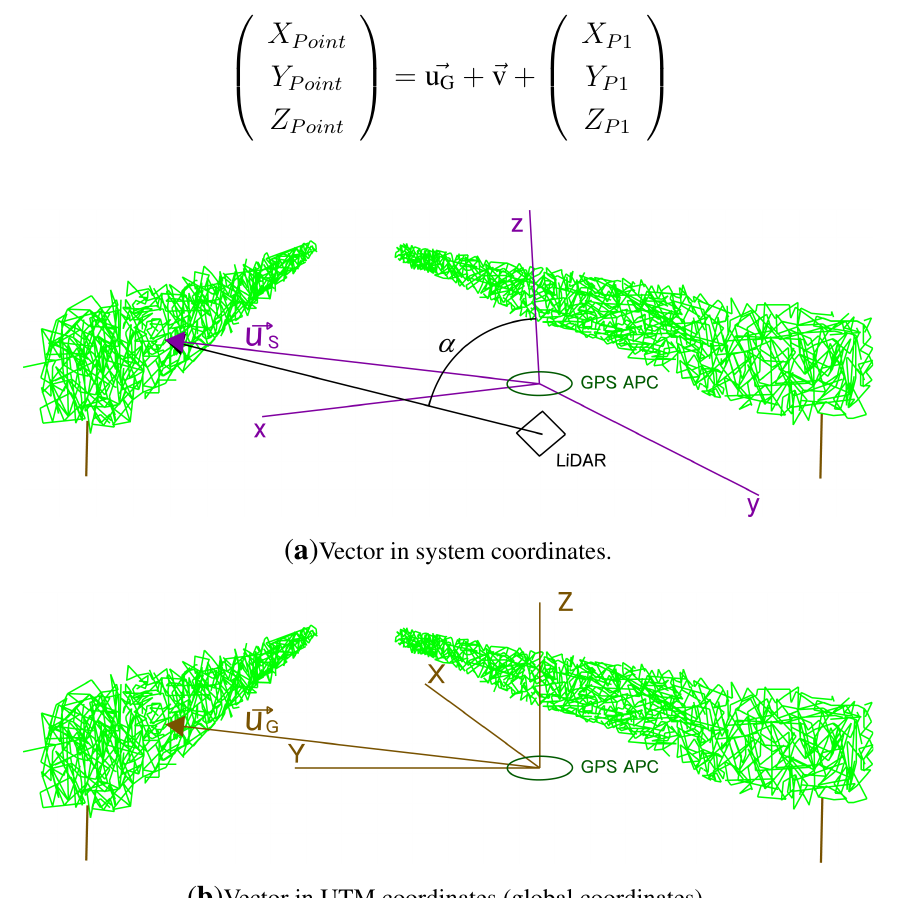
Figure 5. Vector coordinates ( x , y , z ) referring to the GPS APC ( a ) and the vector expressed in UTM coordinates ( X , Y , Z ) ( b